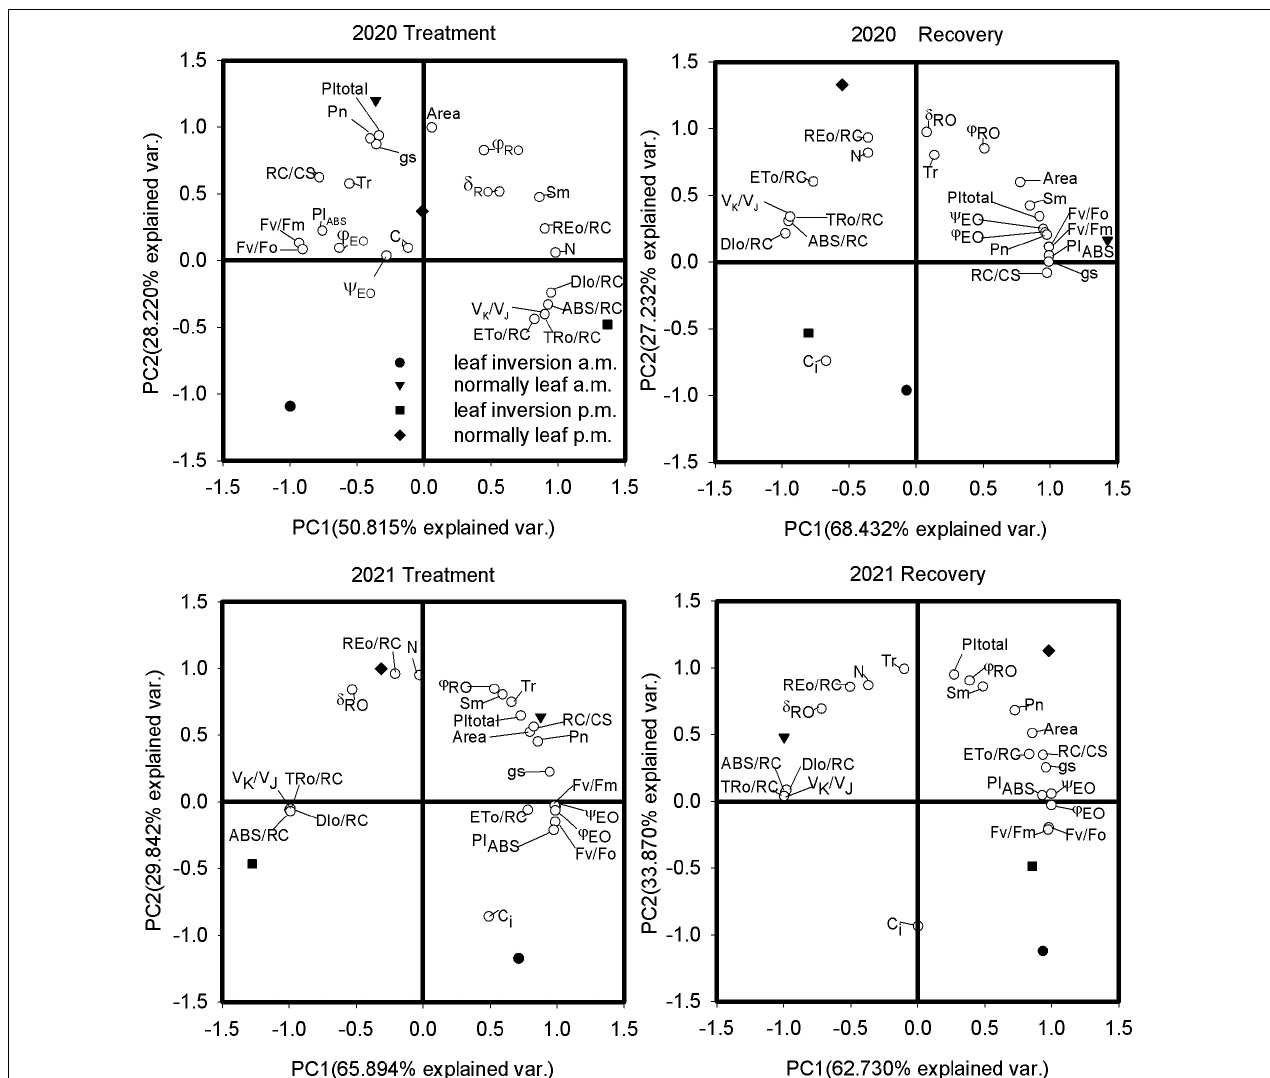
FIGURE 6 | Principal component analysis of variability of JIP-test and gas exchange parameters of soybean leaves for 10 and 15 days (recovery) after leaf inversion in 2020 and